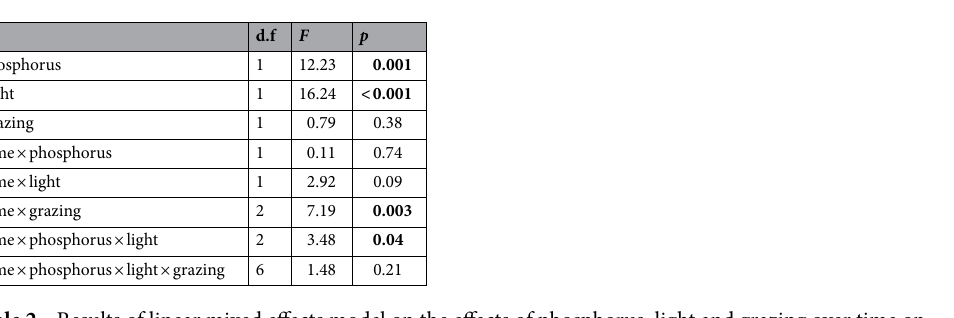
Table 2. Results of linear mixed effects model on the effects of phosphorus, light and grazing over time on periphyton dry mass. Significant effects ( p < 0.05) are highlighted in